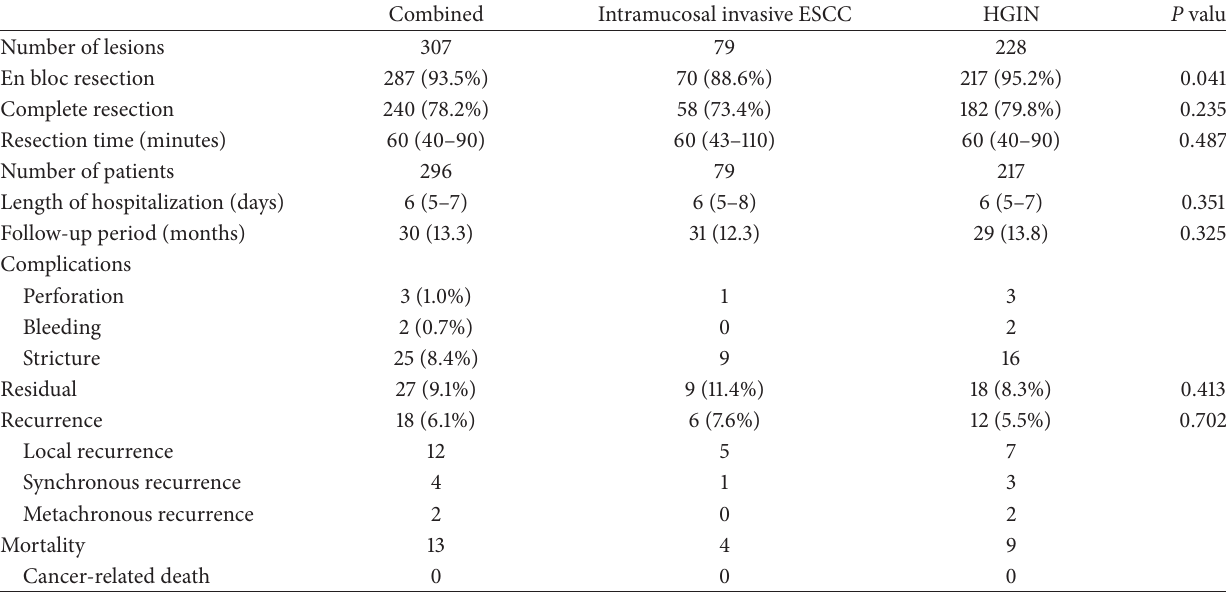
Table 2: Endoscopic treatment/patients’ clinical course after